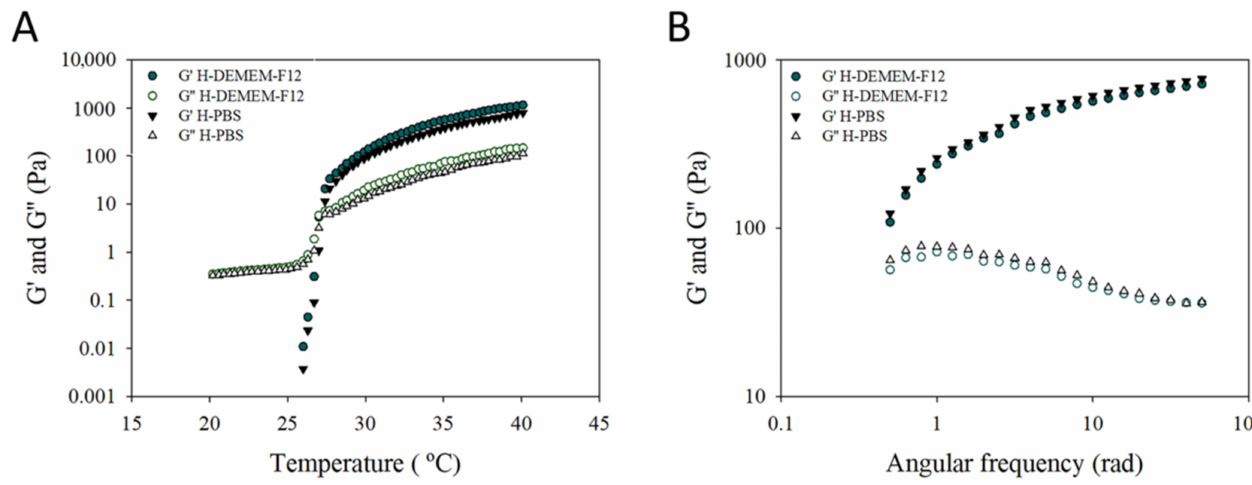
Figure 3. Variation of the storage (G (cid:48) ) and loss (G (cid:48)(cid:48) ) moduli as a function of temperature ( A ) and angular frequency at 37 ◦ C ( B ) for H-DMEM-F12 and H-PBS. The crossover between both moduli is represented by